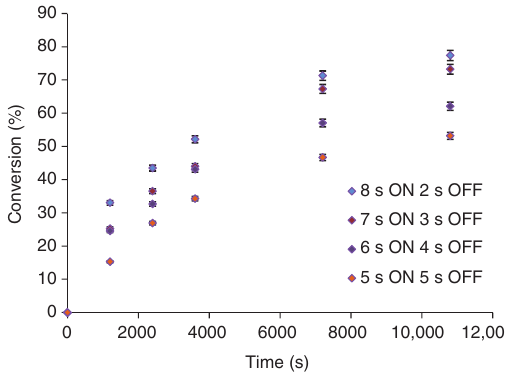
Figure 12 Effect of ultrasonic duty cycle on the percentage conversion.